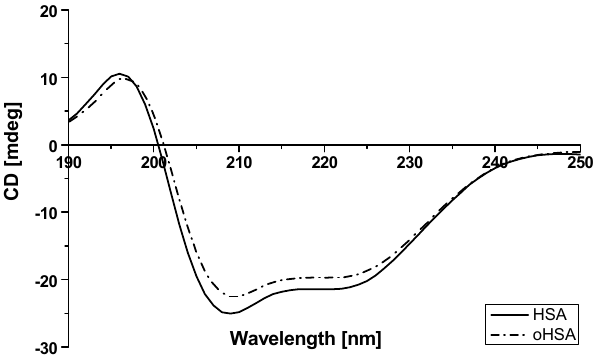
Figure 5. Circular dichroism (CD) spectra of HSA and oHSA at 1·10 − 6 mol·L –1 concentration. Table 3. [ θ MRW ] at λ min for 1 × 10 − 6 mol · L − 1 HSA and